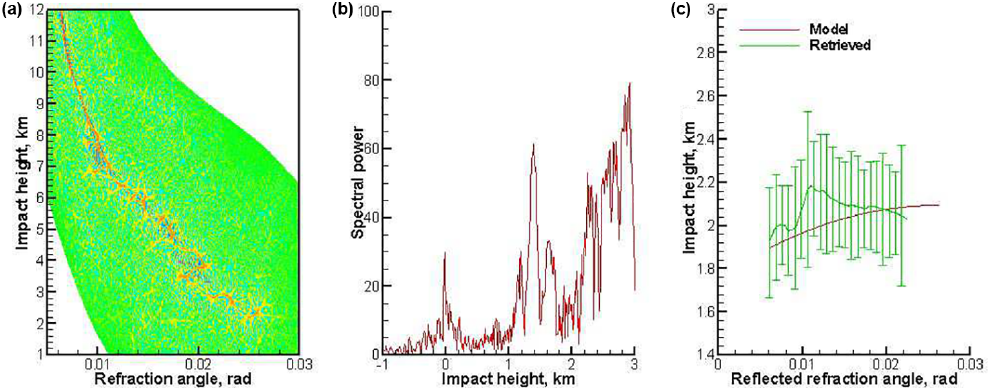
Figure 12. Occultation event 1 January 2008, 04:39:47UTC, 44.78 ◦ N 44.75 ◦ W. Expressed as a: (a) Wigner distribution function; (b) radio holographic spectrum; (c) model and retrieved reflection bending angles, the latter with error bars indicating the uncertainty estimate. Reflection index